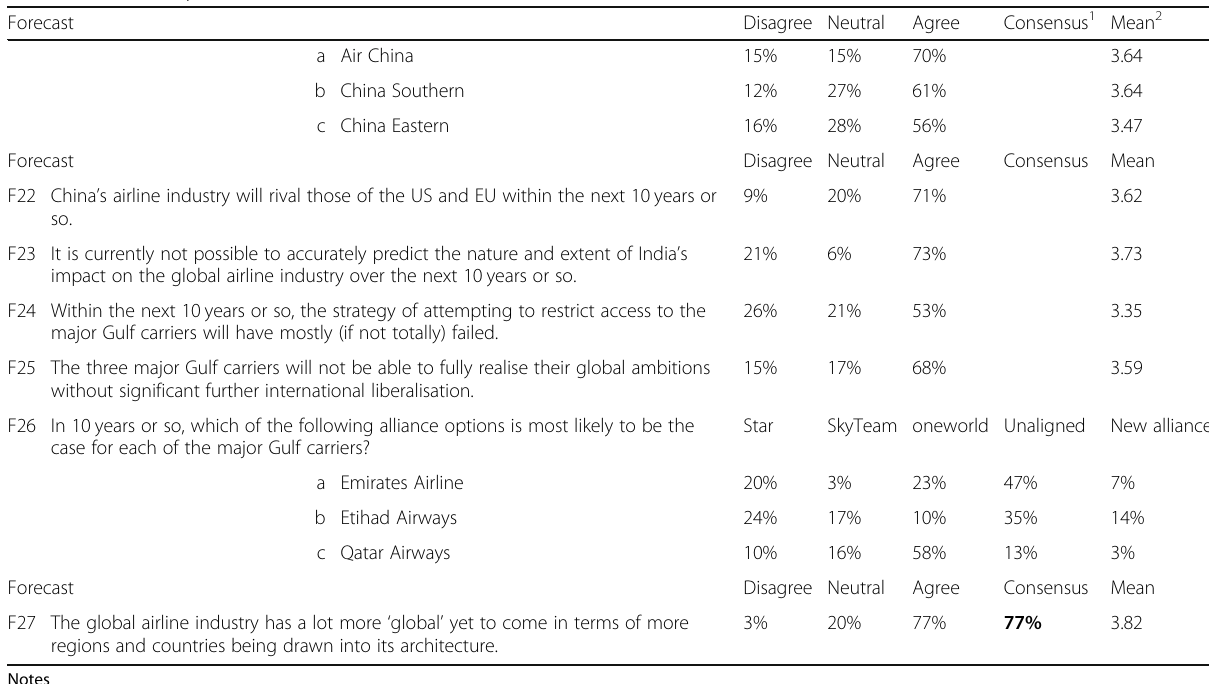
Table 2 Main survey 2: 27 forecasts (Continued)